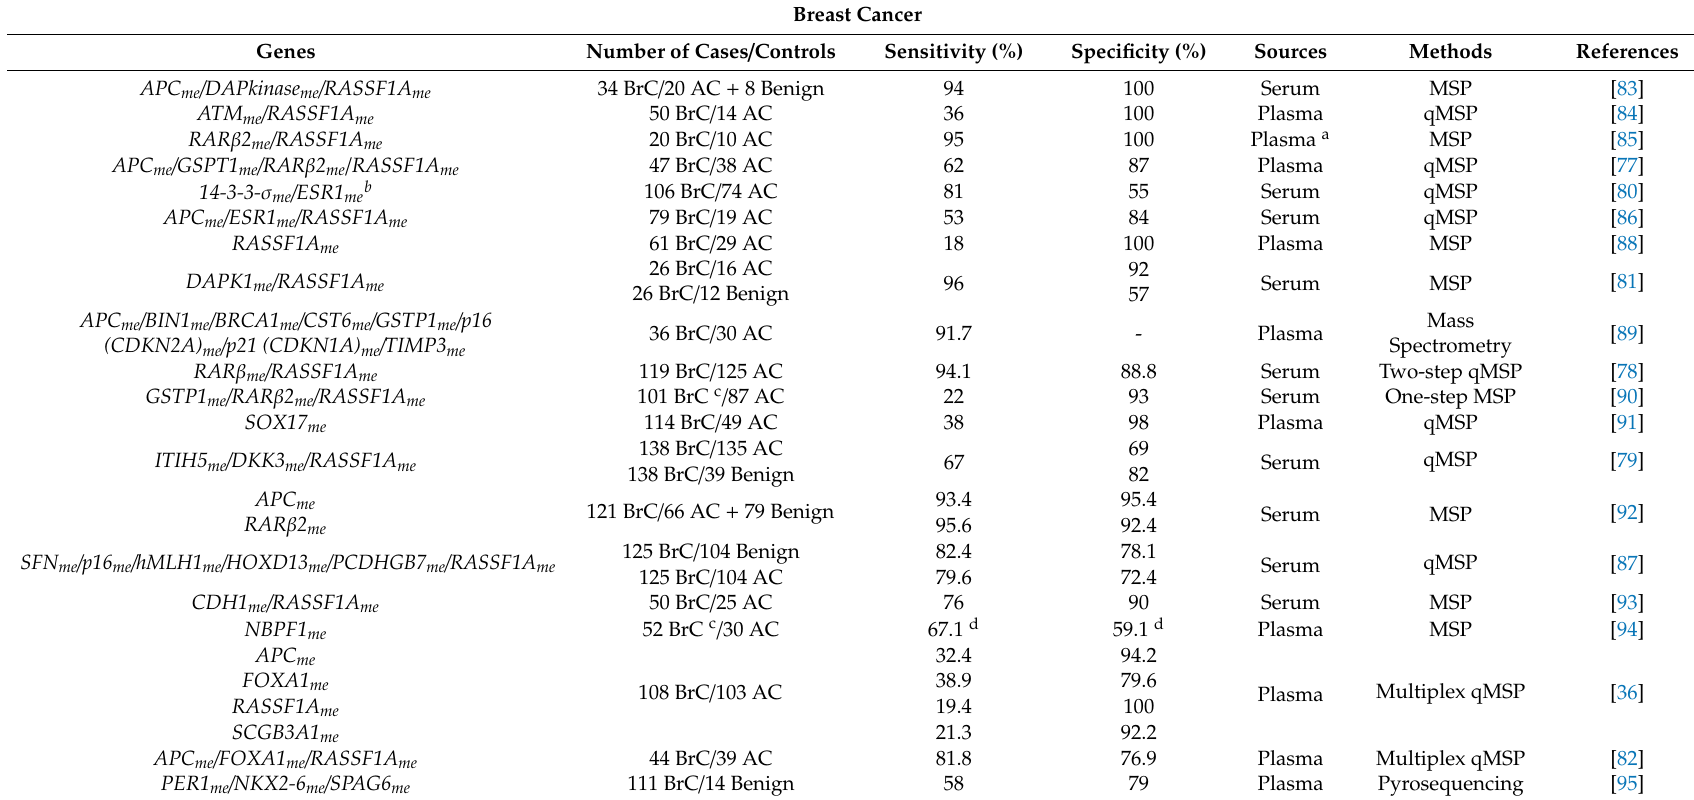
Table 2. CcfDNA-based methylation biomarkers for breast cancer (BrC)